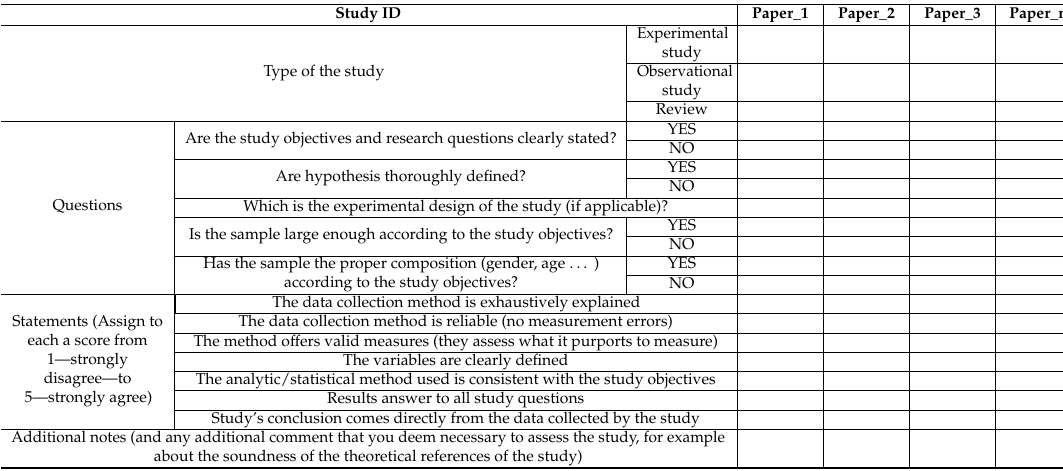
Table A3. Methodological Screening: Quantitative.